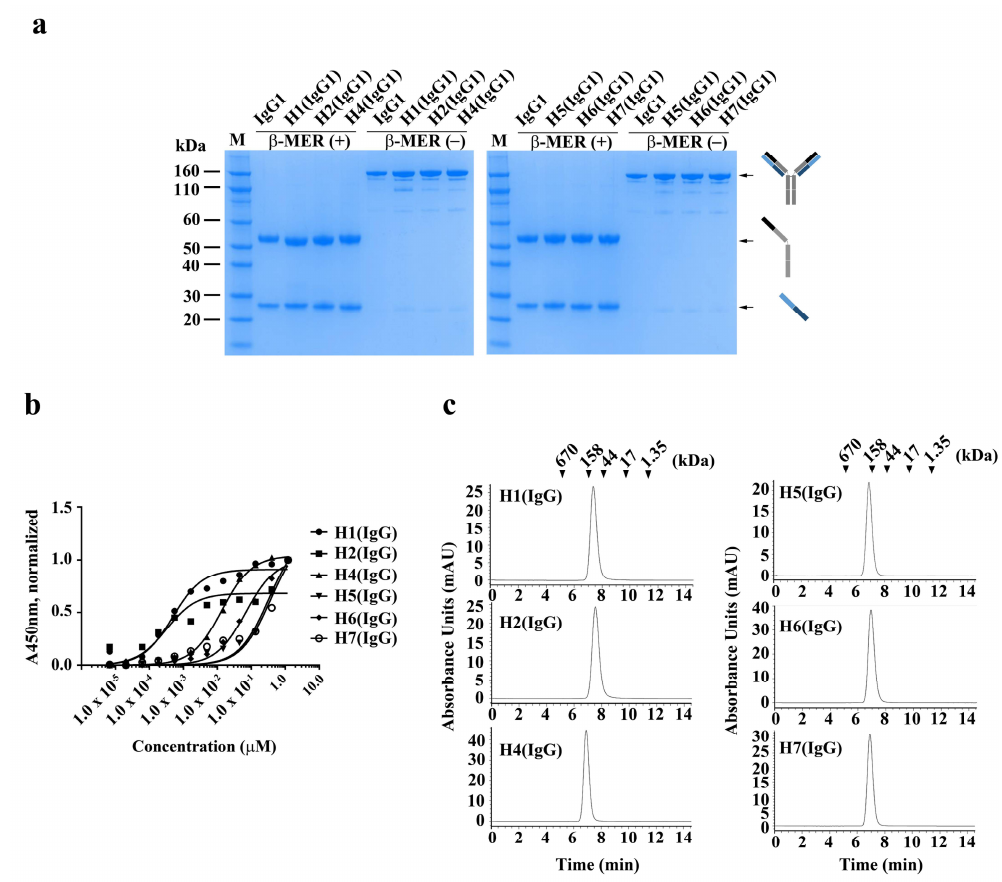
Figure 3. Production and characterization of anti-hYKL-40 IgGs. ( a ) SDS-PAGE analysis of three human anti-hYKL-40 IgGs, H1 (IgG), H2 (IgG), and H4 (IgG), purified from the culture media of Expi293F cells, which were transiently transfected with heavy- and light-chain expression vectors. β -MER ( + ) and β -MER ( − ) indicate with and without the reducing reagent ( β -mercaptoethanol), respectively. ( b ) Soluble ELISA of serially diluted H1 (IgG), H2 (IgG), and H4 (IgG) on immobilized hYKL-40 surfaces to measure their apparent a ffi nities ( EC 50 , nM). ( c ) Size-exclusion chromatography analysis of H1 (IgG), H2 (IgG), and H4 (IgG). The positions of the molecular mass markers, shown as kDa, on the retention time x -axis are shown above the peaks.